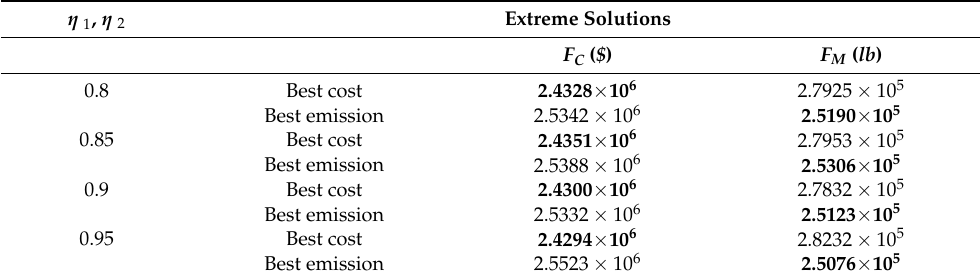
Table 10. The extreme solutions obtained at different confidence levels.